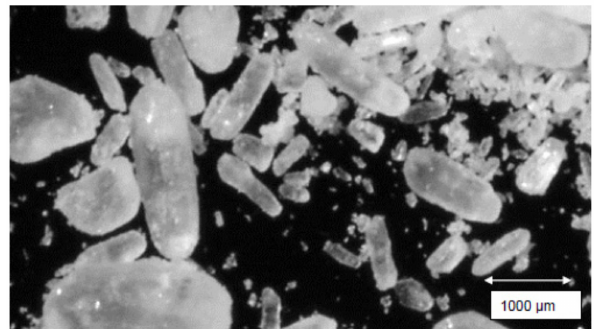
Figure 2. Optical characterization of commercial market product (broad crystal size distribution and elongated crystal